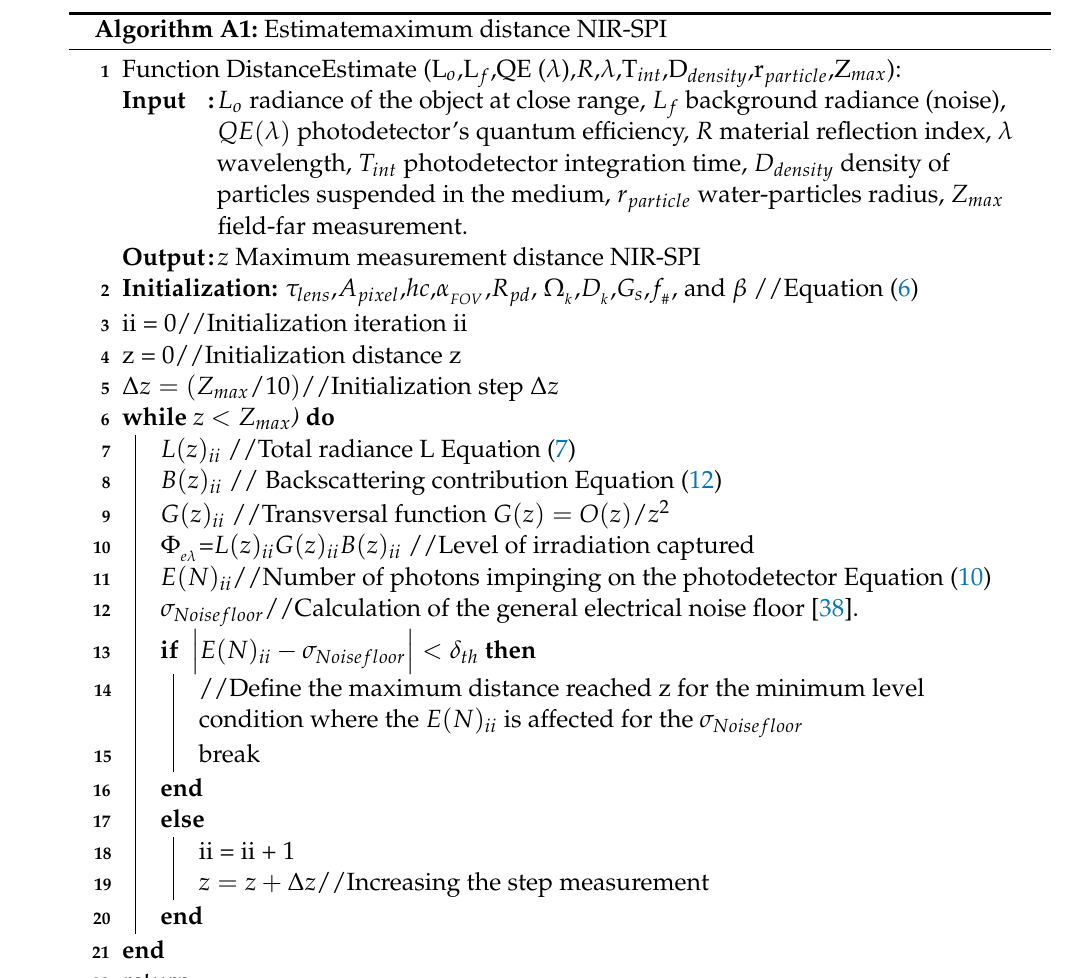
Algorithm A1: Estimatemaximum distance